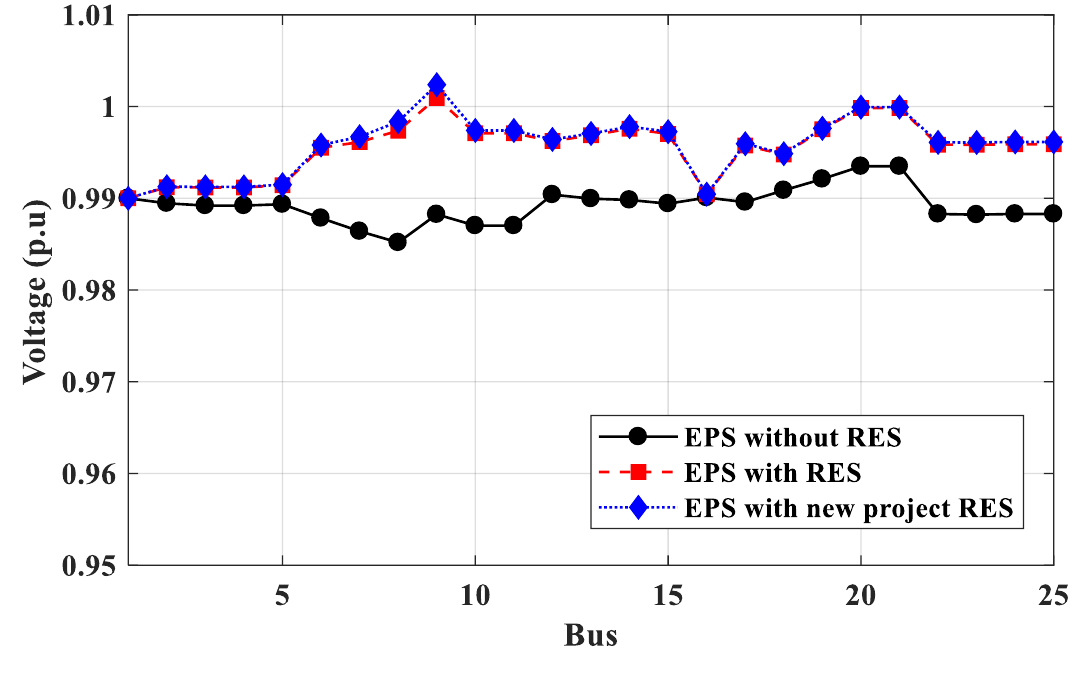
Figure 23. Voltage profile of EPS.